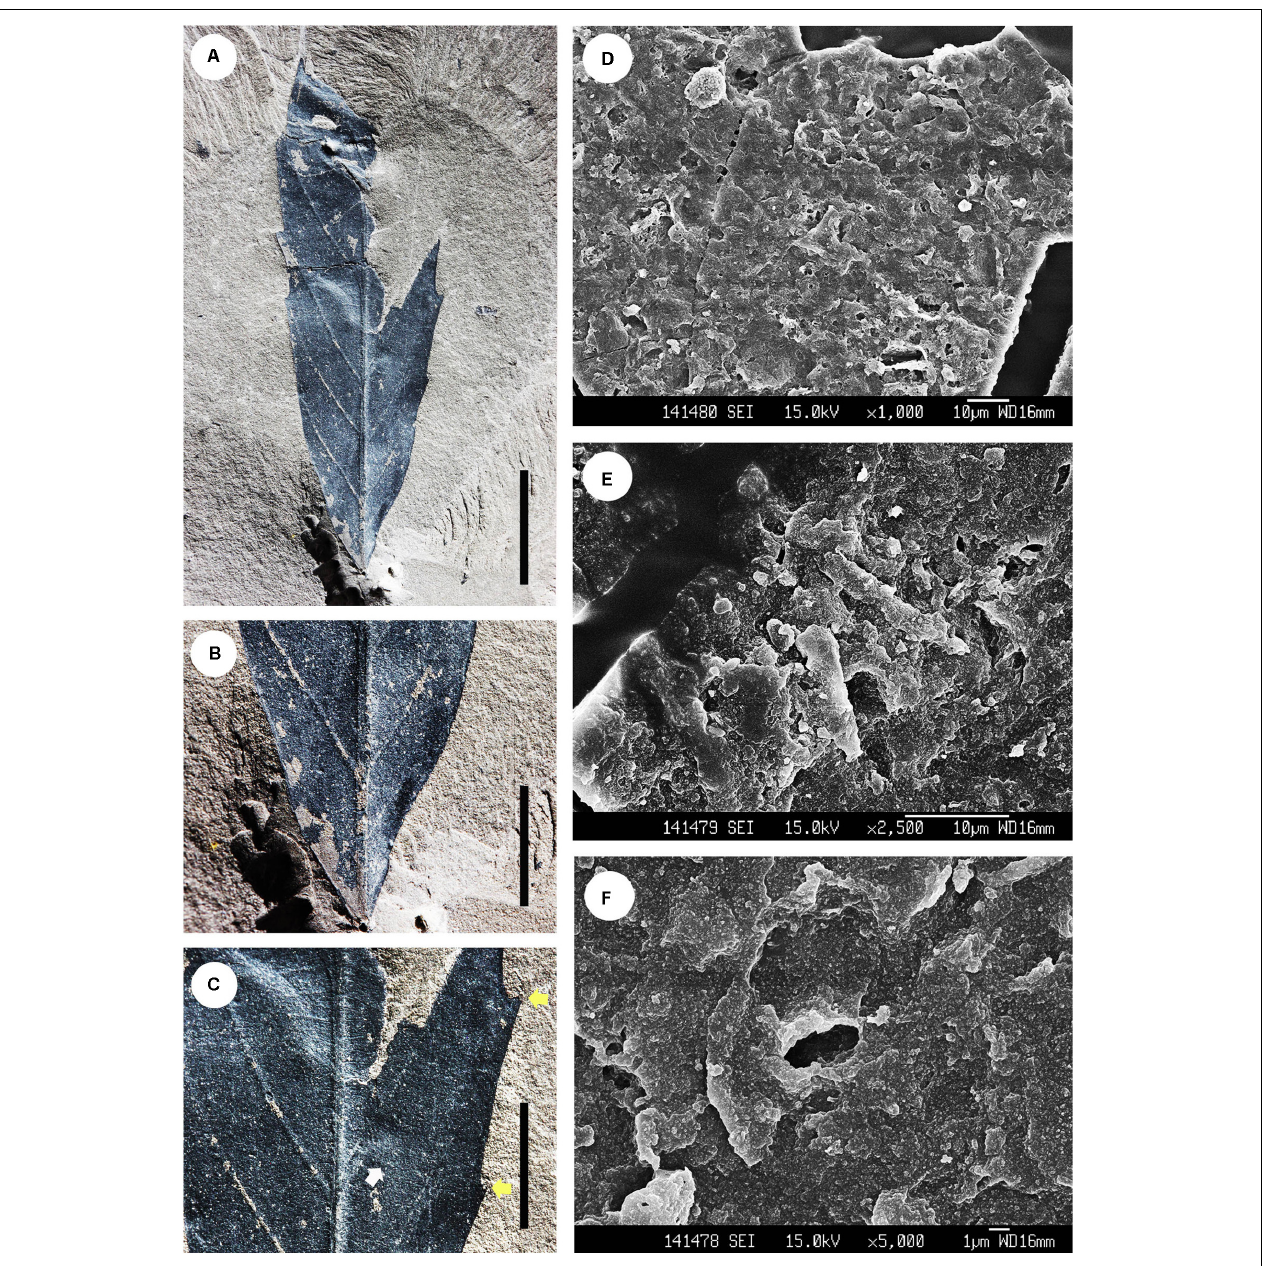
FIGURE 3 | Morphology of Berryophyllum relongtanense (Colani) Z.K. Zhou. (A) Specimen No. CC-998, showing leaf morphology; (B) enlargement of (A) , showing the base of the specimen; (C) enlargement of (A) , yellow arrows indicate leaf margin with teeth, white arrow indicates the tertiary and quaternary venations; (D) SEM image showing rugose structures on the outer surface of leaf; (E) showing solitary trichomes on the outer surface of leaf; (F) showing stomata on the outer surface of leaf. Scale bars: 10 mm (A) ; 5 mm (B,C)